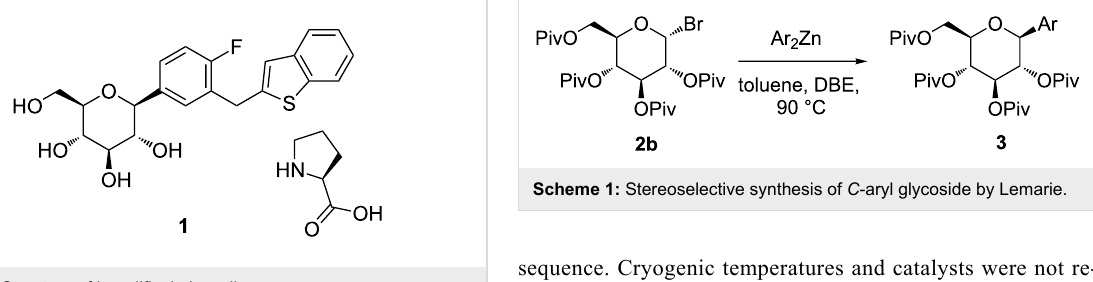
SGLT-2 inhibitors have the common pharmacophore of β - C - arylglucoside, and the synthesis of β - C -arylglucoside including